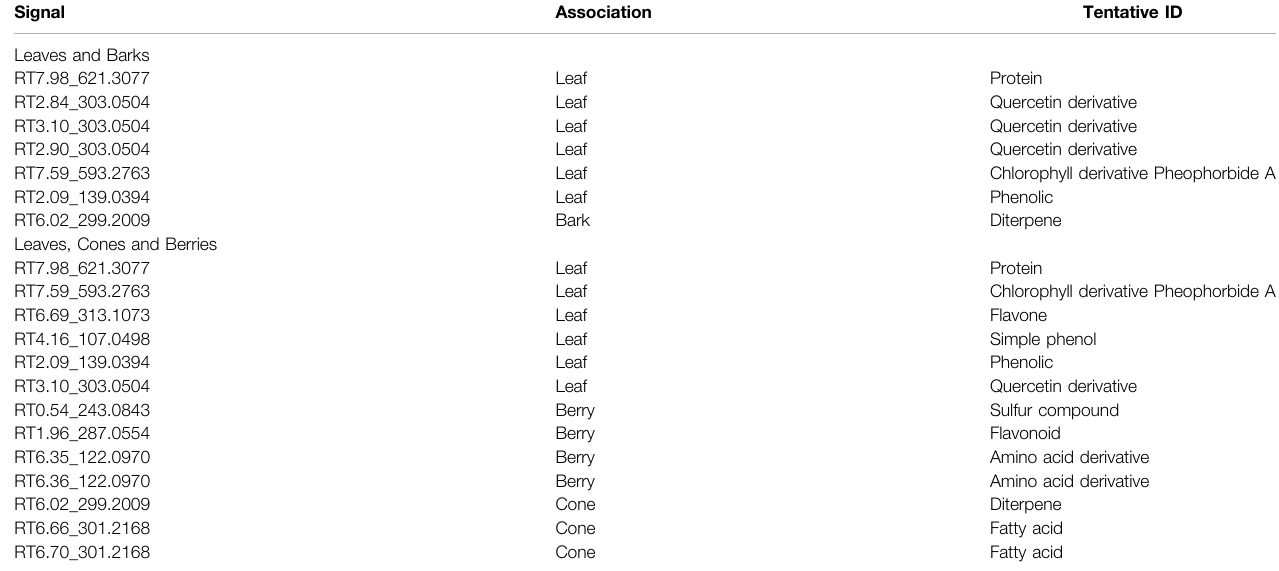
TABLE 3 | Key signals (retention time and calibrated mass/charge ratio) identi fi ed through evaluation of multivariate analysis loadings fi gures. Signal Tentative ID Leaves and Barks